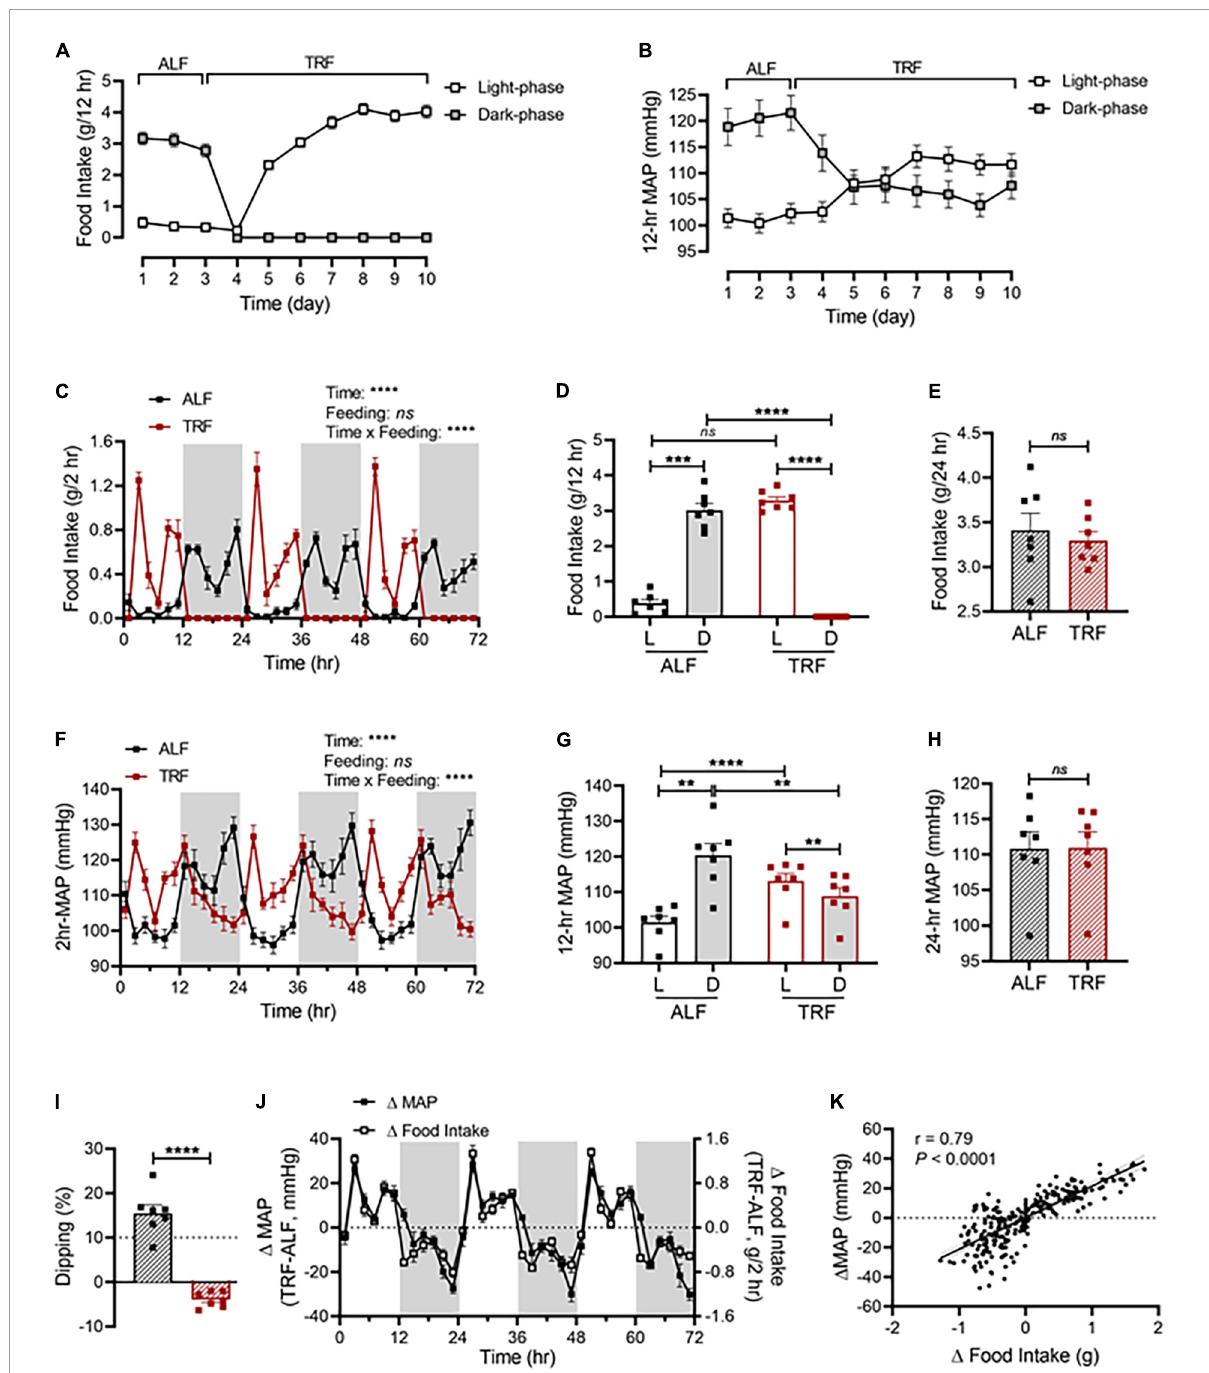
FIGURE2 Light-phase TRF rapidly alters BP rhythm. (A,B) Accumulated food intake (A) and average MAP (B) during the light and dark phase in 17-week-old male C57BL/6J mice ( N = 7) under 3 days of ALF, followed by 7 days of TRF. (C–E) Accumulated food intake in 2-h (C) , 12-h (D) , and 24-h (E) intervals over 3 days under ALF and during the last 3 days under light-phase TRF. (F–H) Average MAP in 2-h (F) , 12-h (G) , and 24-h (H) intervals over 3 days of ALF and the last 3 days under light-phase TRF. (I) MAP dipping with ALF and reverse dipping with light-phase TRF. (J) Net changes in accumulated food intake ( (cid:49) food intake) and average MAP ( (cid:49) MAP) in 2-h intervals over 72 h. (K) Linear regression of (cid:49) food intake and (cid:49) MAP. Data were expressed as the mean ± SEM and analyzed by repeated two-way ANOVA with matching conditions between light vs. dark phase and between ALF vs. light-phase TRF with Tucky’s post-hoc analysis (C,D,F,G) , paired t -test (E,H,I) , and simple linear regression (K) .** P < 0.01; *** P < 0.001; **** P < 0.0001; ns, not